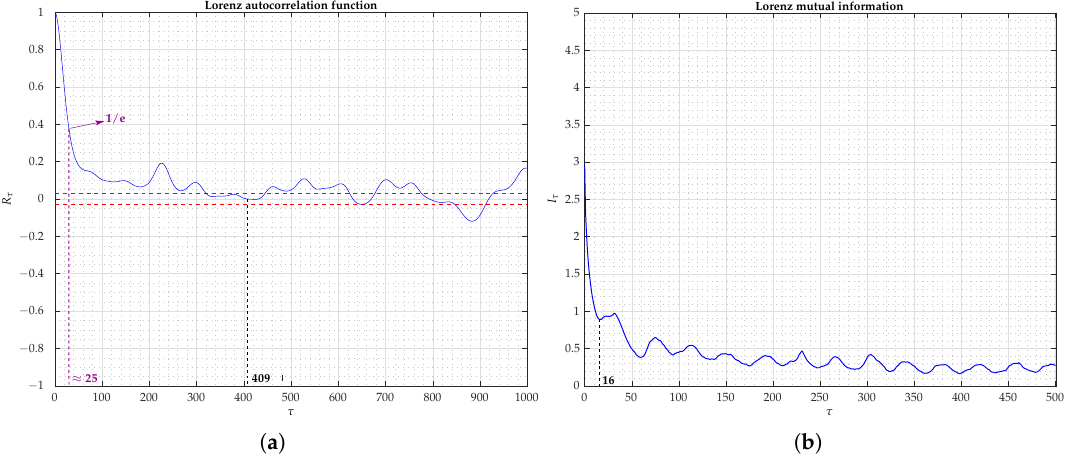
Figure 7. From the dynamic variable x of the Lorenz attractor: ( a ) autocorrelation function (AF), where the first zero crossing is when τ = 409; and ( b ) mutual information (MI), where the first minimum is with τ =